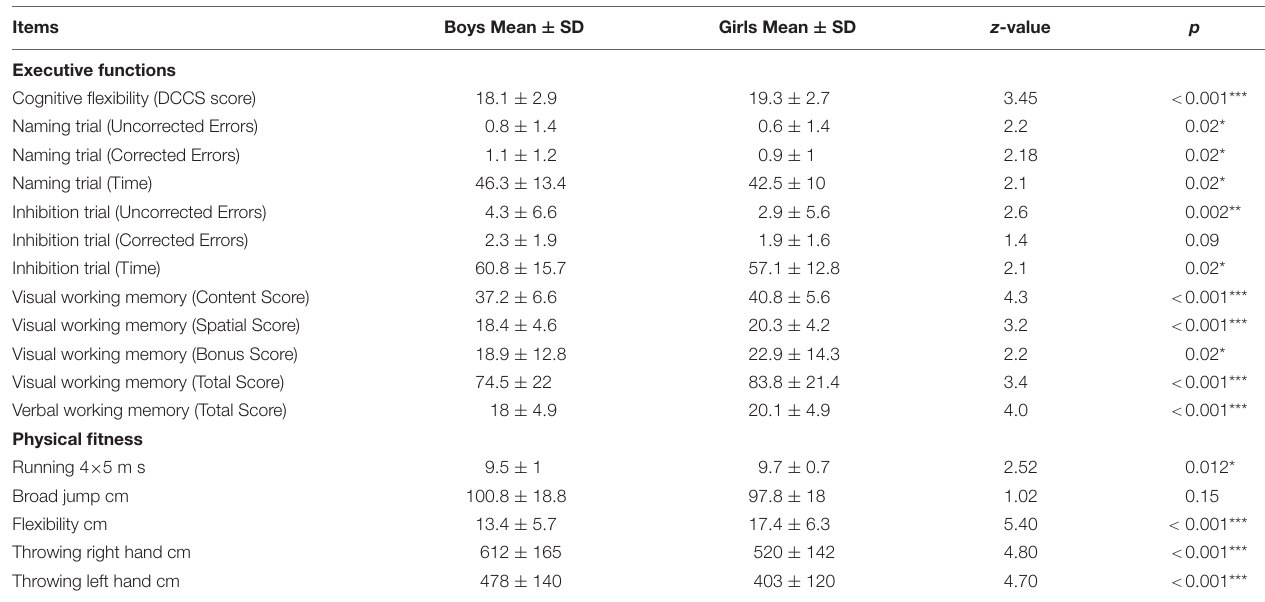
TABLE 2 | Sex differences in executive function and physical fitness